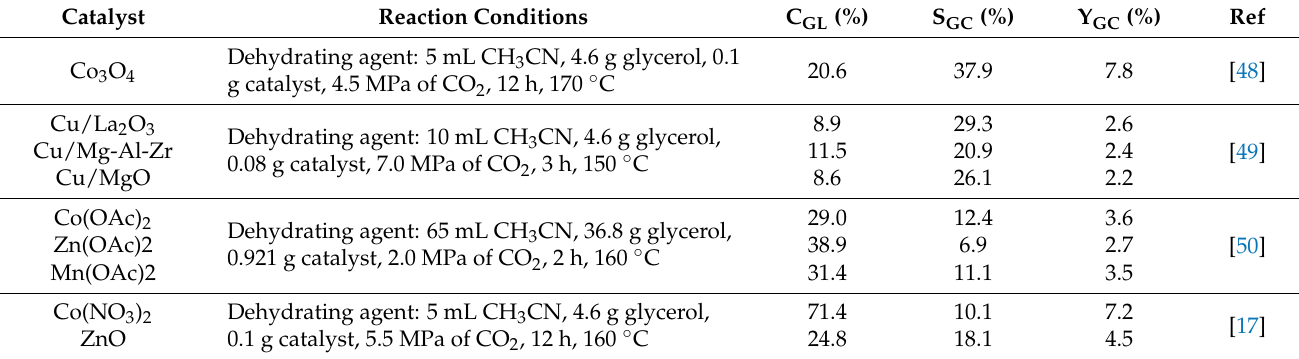
Table 3. Catalytic conversion of CO 2 and glycerol into GC over different heterogeneous catalysts reported